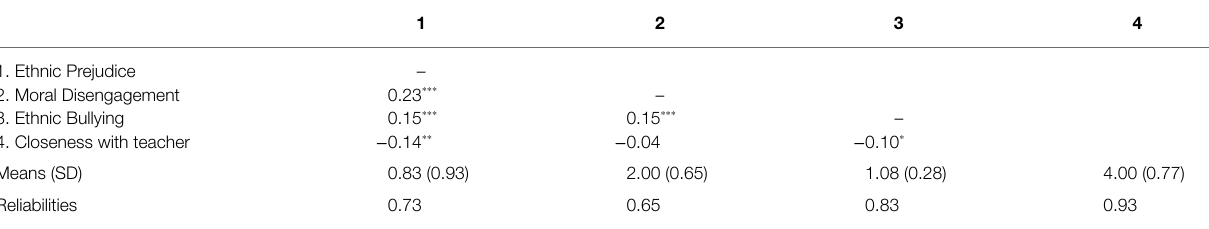
TABLE 1 | Descriptive statistics and bivariate correlations among study variables.